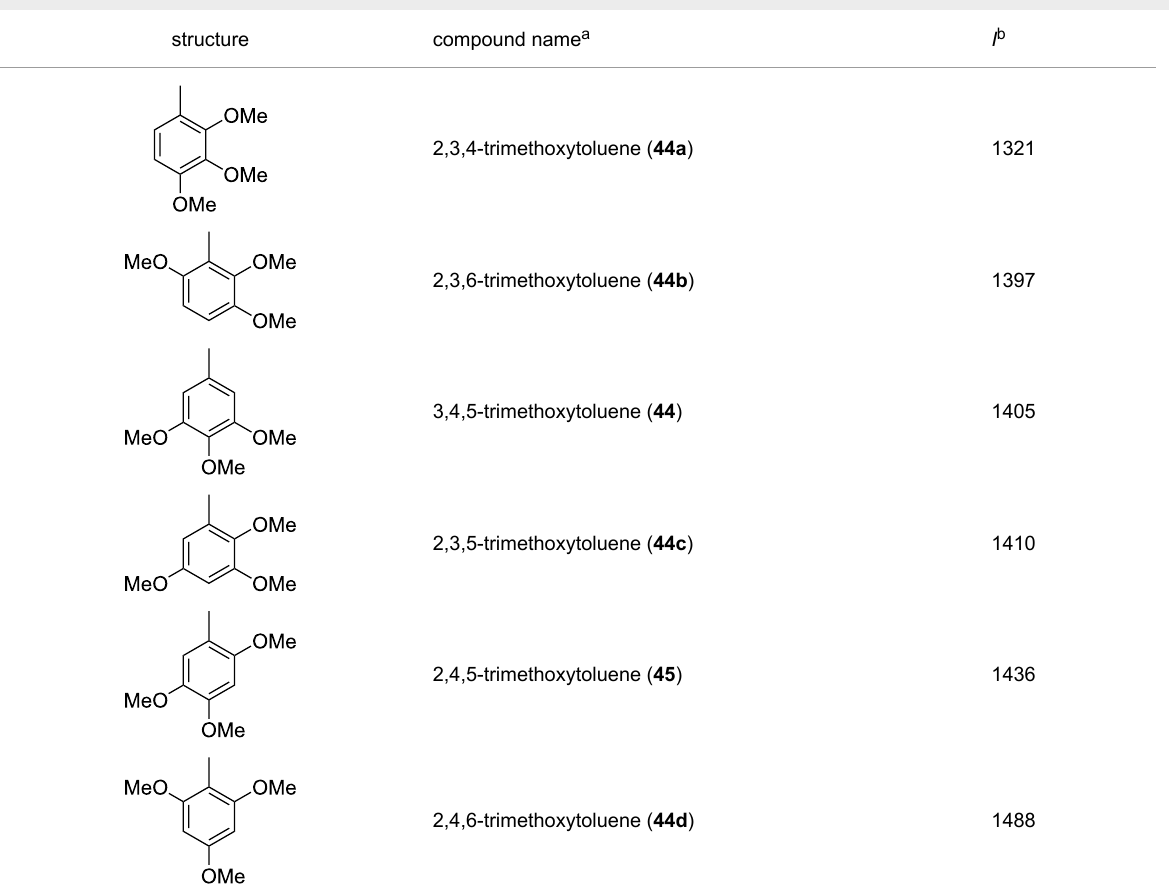
Table 7: Retention indices of all isomers of